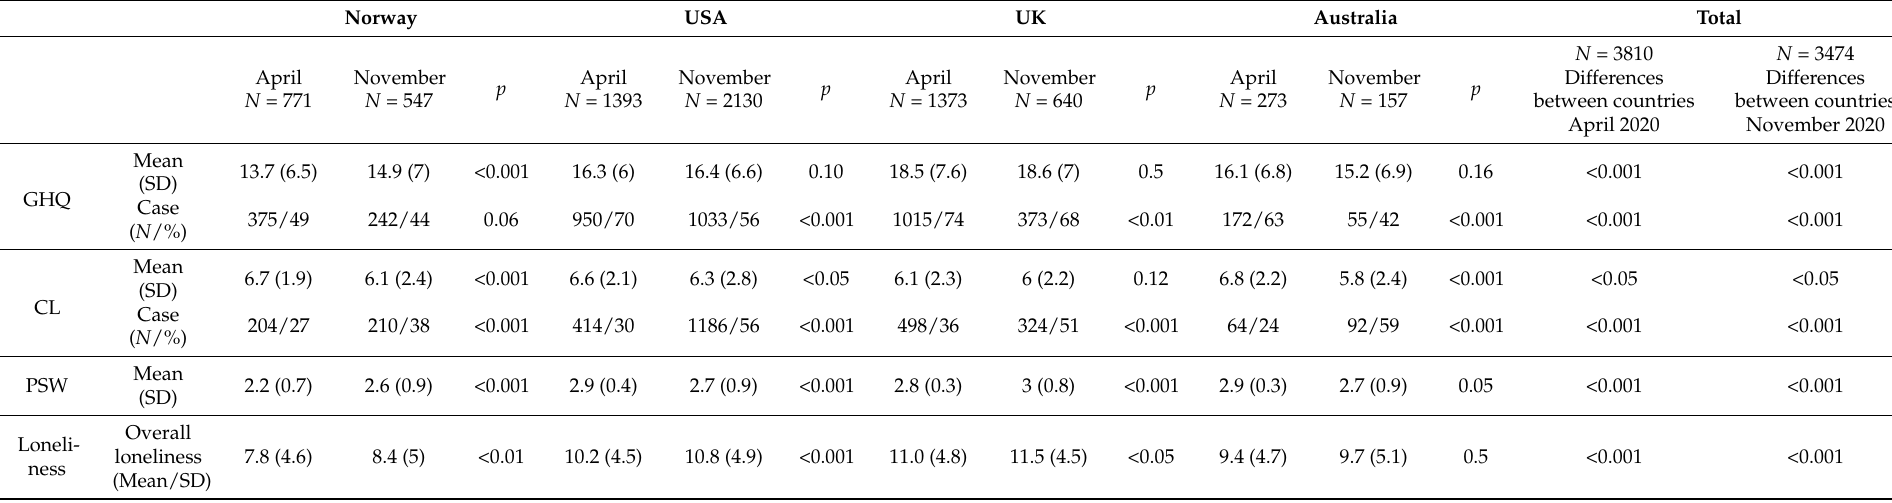
Table 3. Comparison of mental health, overall quality of life, psychosocial well-being and loneliness between the national samples and between the countries in April and November 2020. Norway USA UK Australia